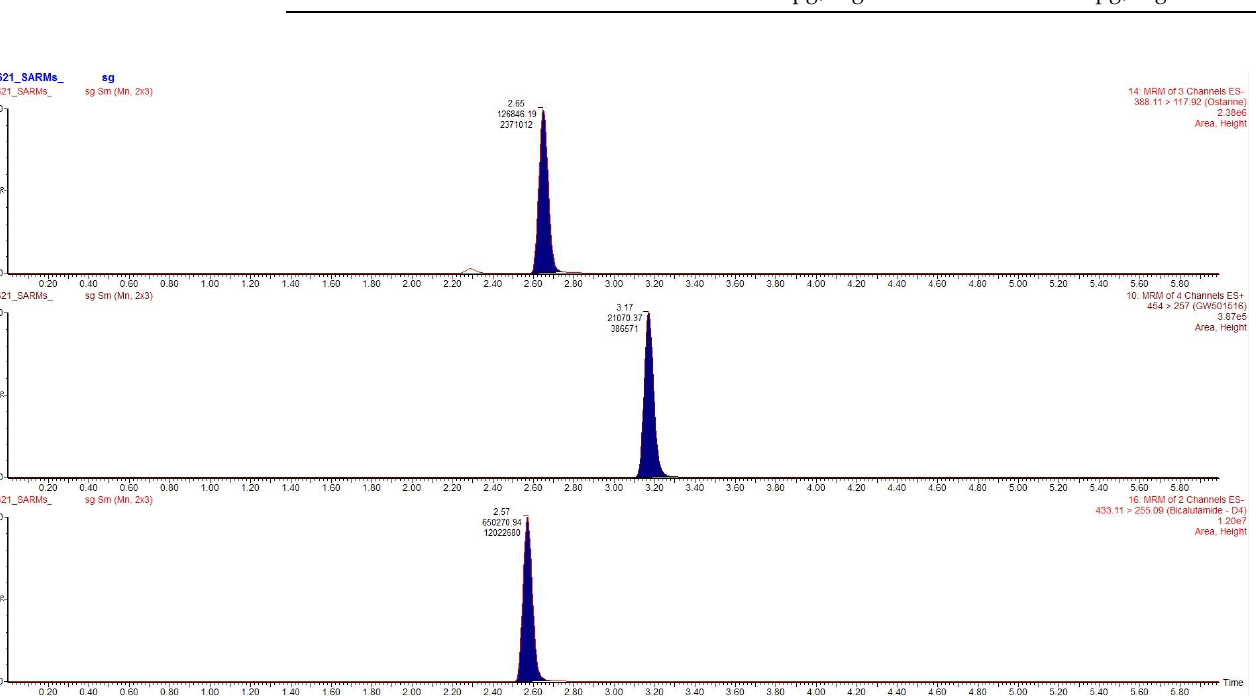
Figure 2. Chromatogram obtained after extraction of the blood. From top to bottom: ostarine (1 ng/mL), cardarine (403 ng/mL) and the internal standard.